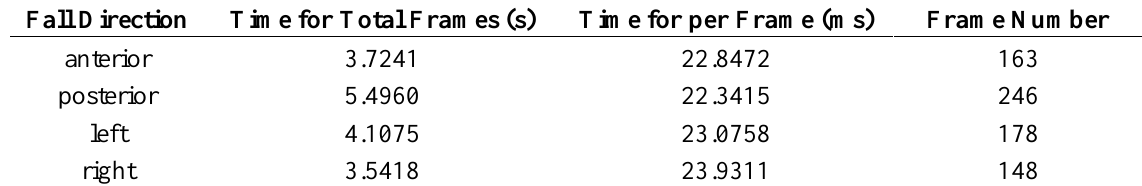
Table 1. Time consumption of the proposed